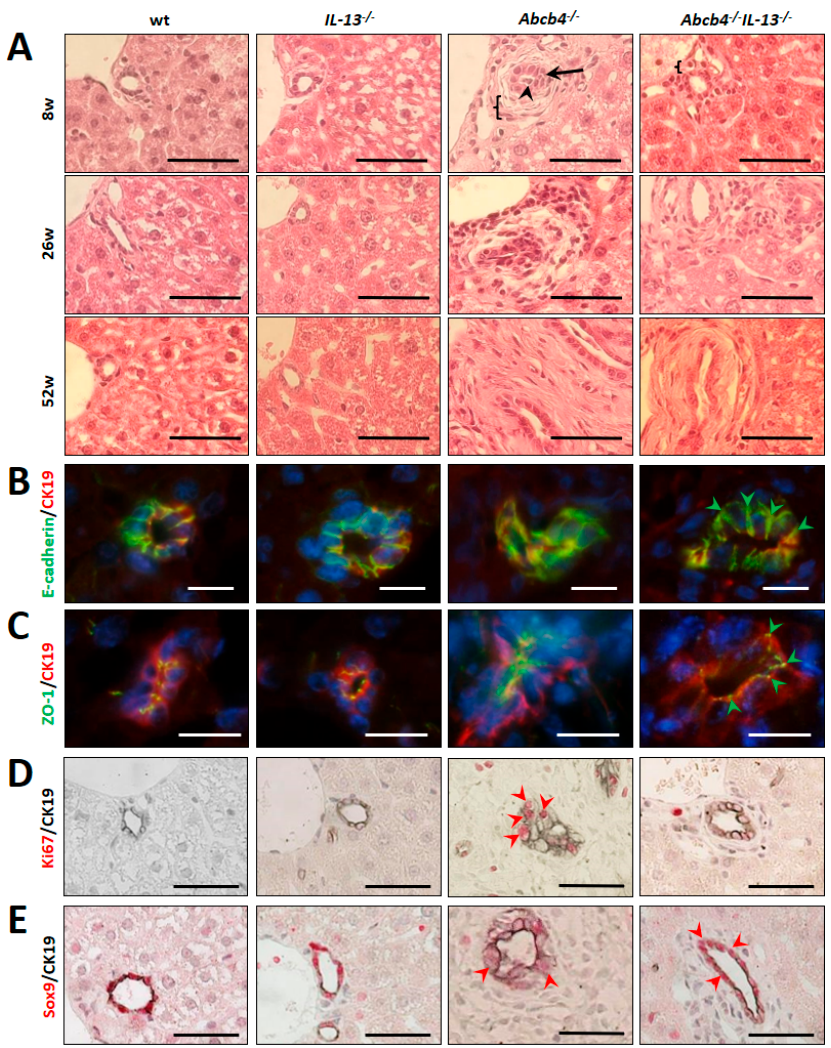
Figure 1. IL-13 knockout restored bile duct architecture in Abcb4 − / − mice. ( A ) Hematoxylin and eosin (H & E)-staining demonstrated loss of lumenization or bile duct collapse (arrowhead), massive proliferation of biliary cells (arrow), thickening of mesenchymal layer (bracket), swelling of biliary epithelial cells (BECs), and altered BEC organization (arrows) in Abcb4 − / − mice. In contrast, appearance of BEC and bile duct morphology was preserved in Abcb4 − / − mice with IL-13 knockout and biliary architecture were preserved (arrowheads). H & E staining and histological scoring by an expert (U.D.) were performed for all mice in this study ( n = 10 per group, 120 sections). ( B,C ) Immunostaining of CK19 (red) and ( B ) E-cadherin (green) as well as ( C ) ZO-1 (green) accentuated structural preservation of distinct biliary cell contacts and sharply stained tight junctions in Abcb4 − / − /IL-13 − / − mice in comparison to Abcb4 − / − mice (arrowheads). Abcb4 − / − showed altered tight junction morphology characterized by an altered, partially disrupted, ZO-1 staining pattern between BECs. ( D ) Ki67 staining (red) indicated proliferation of CK19 + -BEC in Abcb4 − / − mice (arrowheads). ( E ) Homogenous staining for BEC-marker Sox9 (red) is almost lost in CK19 + (black) BEC for Abcb4 − / − mice but largely preserved in Abcb4 − / − /IL-13 − / − mice (arrowheads). Immunohistochemistry was performed for 3-4 representative animals per group in 8-week-old animals, 12–16 sections per immunostaining). Representative micrographs are shown. Bars ( A,D,E ) 50 μ m and ( B,C ) 12 μ m, magnification ( A , D , E ) ×400 and ( B , C ) ×1000. − / − / IL-13 − / − While proliferation was a rare event in BECs of controls and in Abcb4 mice, approx. − / − 50% of BECs stained positive for Ki67 in Abcb4 mice, indicating that IL-13 knockout reduced